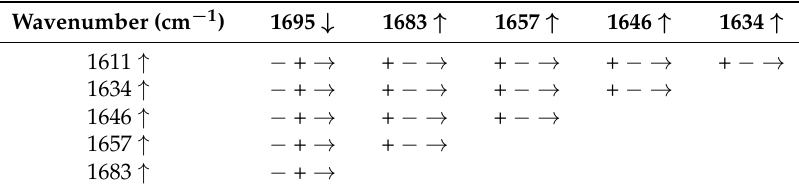
Column and row headings represent the x and y wavenumbers, respectively, from the 2D maps in Figure 6. Vertical arrows represent an increase ( ↑ ) or decrease ( ↓ ) in the band intensity as the temperature increased, as deduced from 1D spectra. The signs “+” and “–“ indicated positive and negative peaks in the 2D synchronous map and asynchronous map, respectively. The sign “ ≈ ” indicated there is no correlation peak is found in the asynchronous map which means both peaks change at the same time. Horizontal arrows indicate that the intensity change at y·cm − 1 occurs before ( → ) or after ( ← ) that at x·cm − 1 .